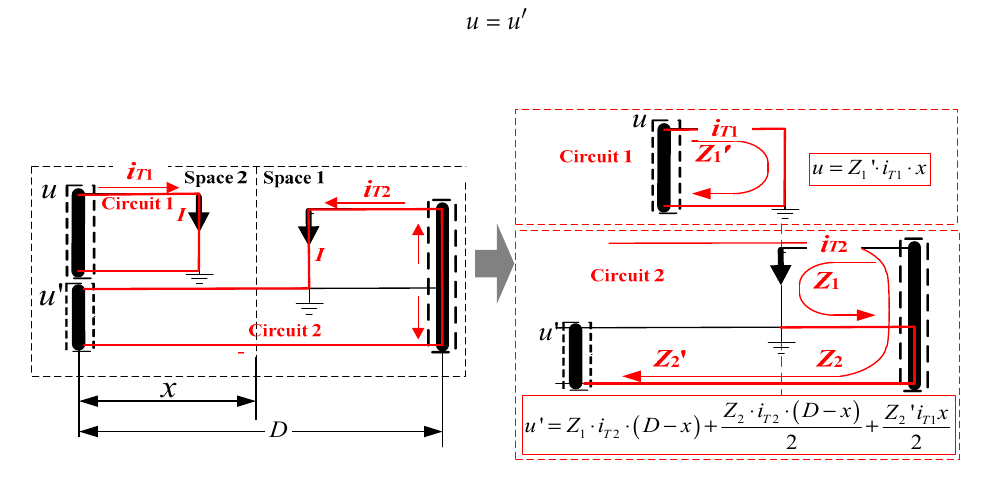
Figure 4. Segment loop circuit network separated by load.